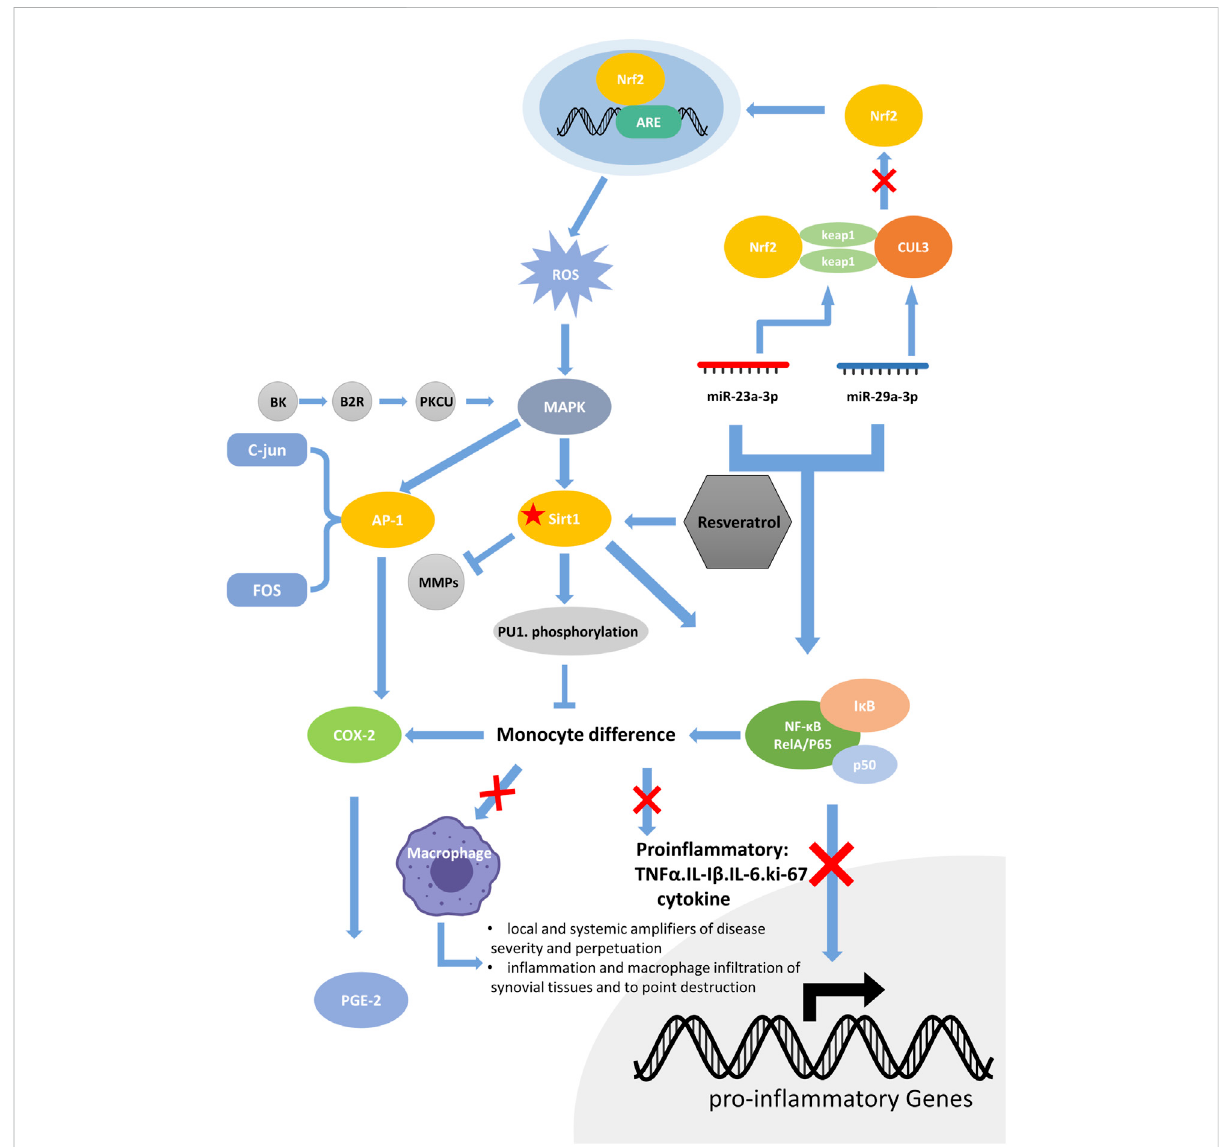
FIGURE 1 The RA molecular regulation chain surrounding SIRT1. SIRT1 can downregulate NF- κ B and MMP1/MMP13, both of which promote the invasion of RA. NF- κ B participates in mir-29a-3p/Keap1 and mir-23a-3p/Cul3. They both regulate downstream Nrf2, mediate ARE expression, and produce ROS. On the other hand, BK/B2R/PKC μ Pathway and Nrf2/ARE/ROS pathway can act on downstream MAPK, which can mediate AP-1 and NF- κ B, thus forming a closed loop of complex signaling pathways starting from the SIRT1